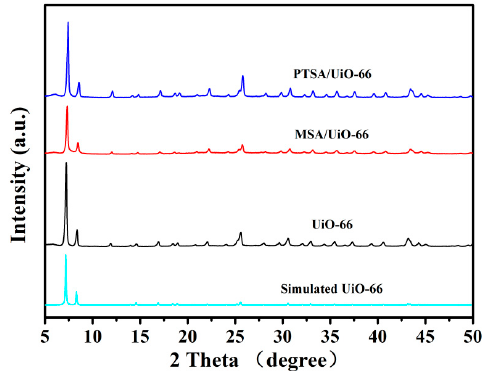
ff raction (XRD) patterns of the prepared UiO-66 and acids supported Figure 1. X-ray diffraction (XRD) patterns of the prepared UiO-66 and acids supported UiO-66. Figure 1. X-ray di